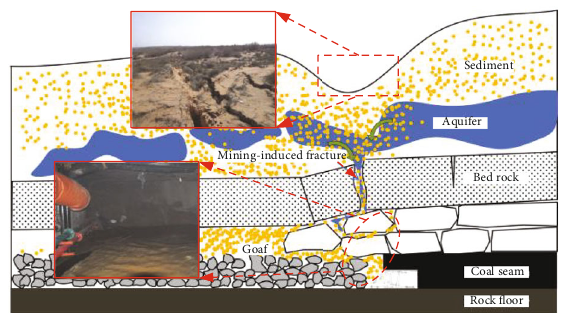
Figure 1: The schematic diagram of the water and sand inrush disasters as well as the images of the disaster on site (after